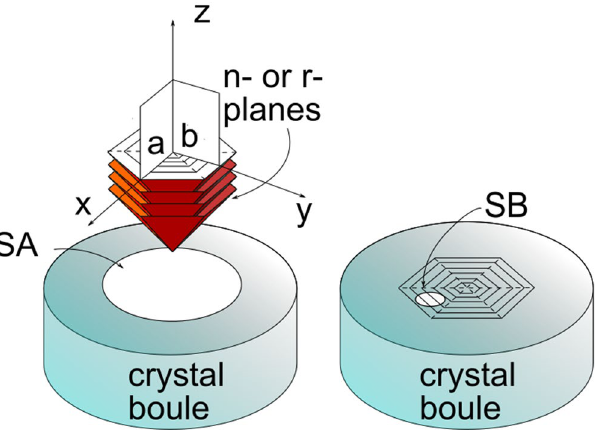
Figure 7. Scheme of the 3D absorption geometry as related to the growth facets associated to the n- and r-crystal plane families. The experimental maps of Fig. 2a,b corresponds to the planes labeled as “a” and “b” respectively. Sample A (SA) and sample B (SB) were carved from two different crystal boules from the positions shown in the